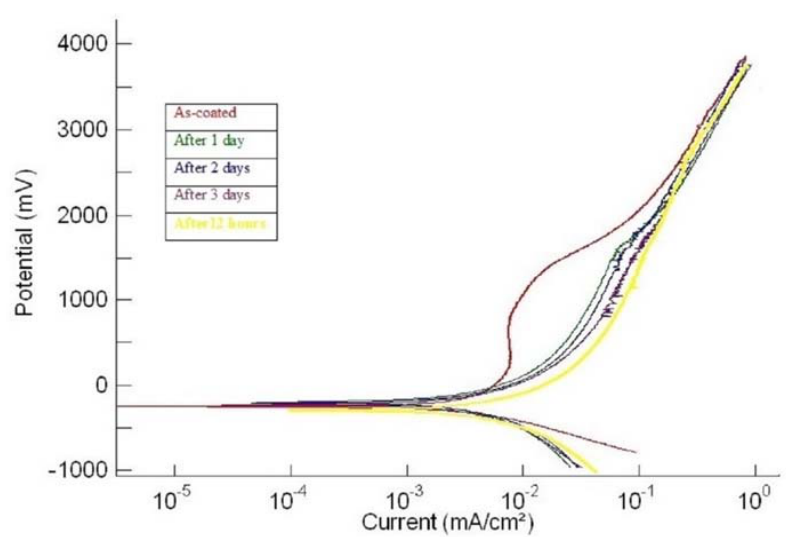
Figure 2. Polarization curves of ‘2hcd’.